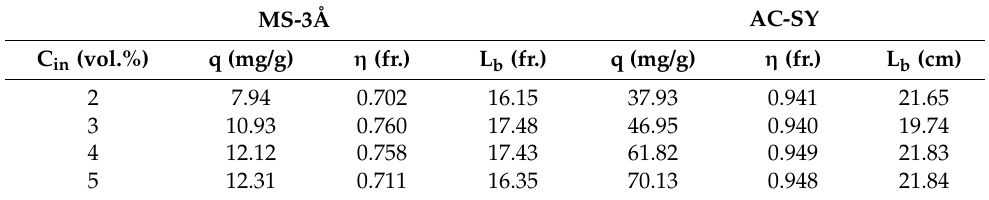
Table 5. Dependence of adsorption performances on initial adsorbate levels (T = 298 K, F = 4